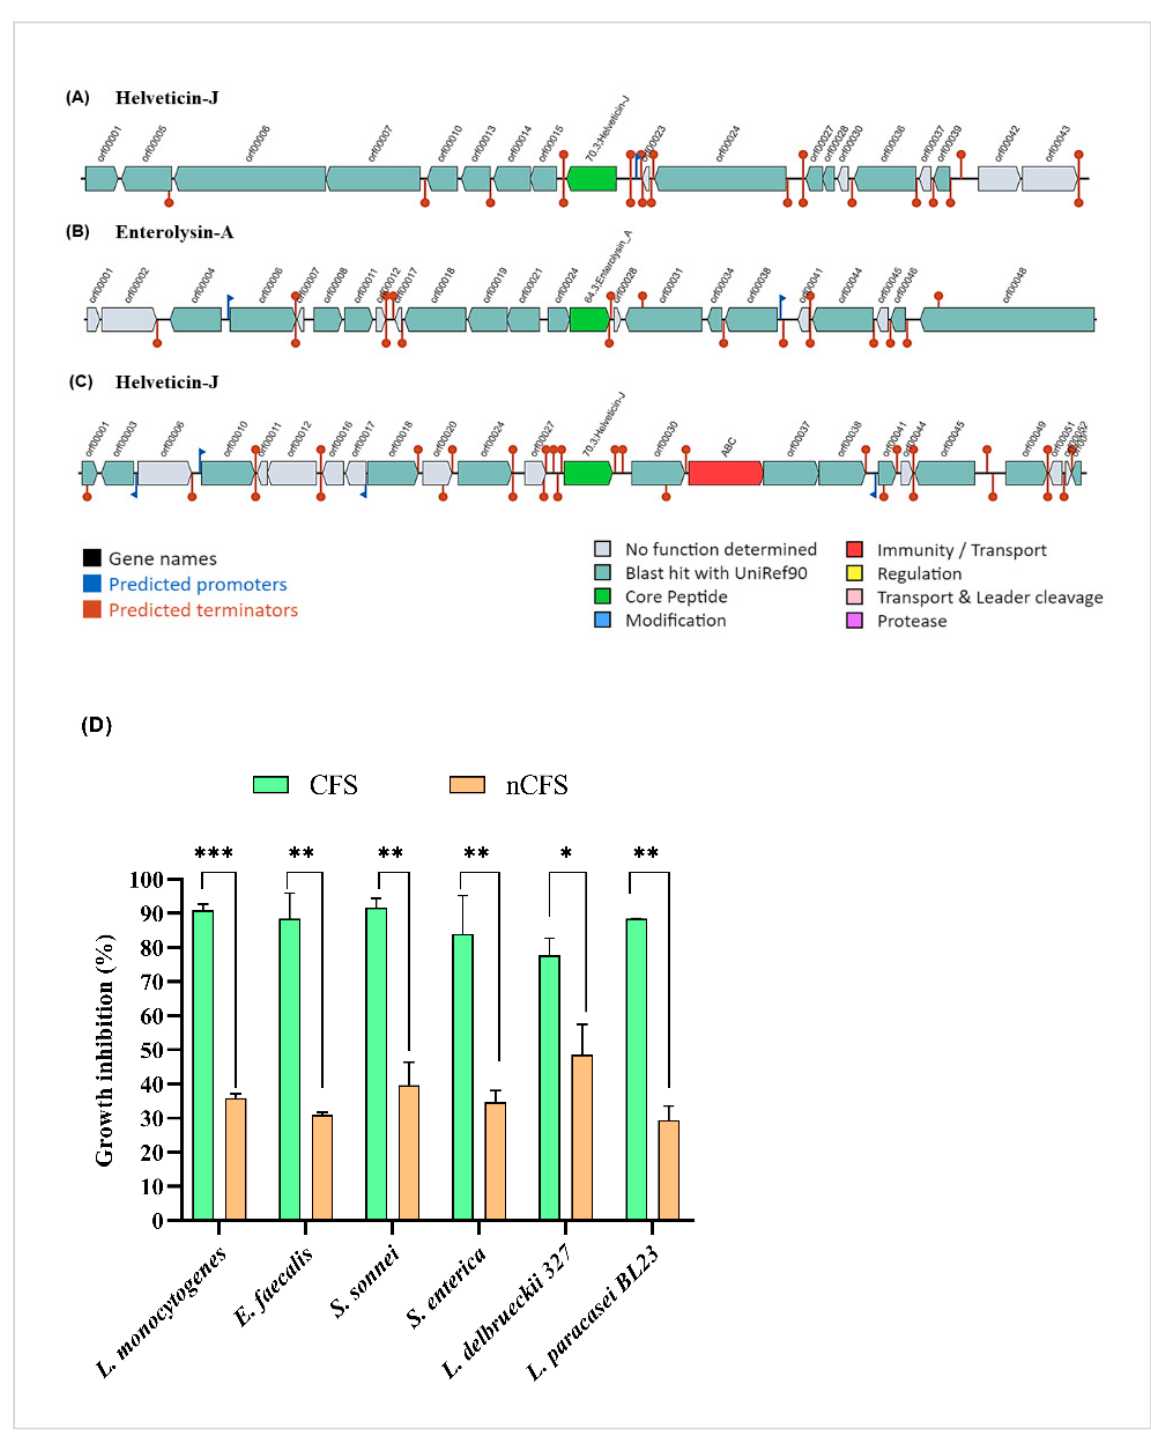
Figure 6. Schematic representation of bacteriocin gene operon ( A – C ) present in L. delbrueckii CIDCA 133 genome predicted by BAGEL4. ( D ) Antibacterial activity spectrum of bacterial supernatants from L. delbrueckii CIDCA 133 against pathogenic and non-pathogenic bacteria. Asterisk indicates statistical difference by Student’s t- test: * p < 0.05, ** p < 0.01, *** p <